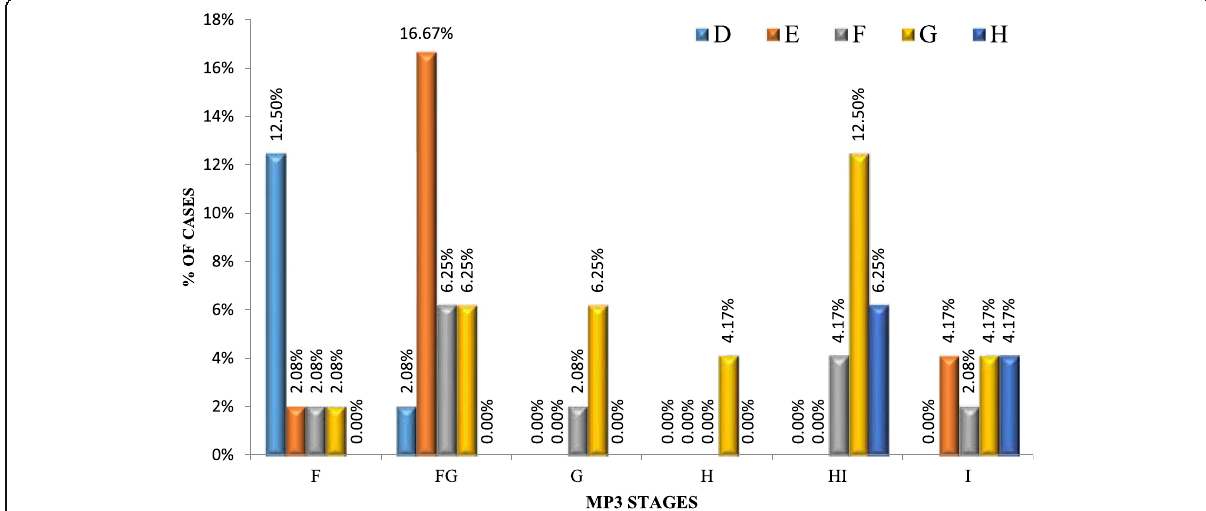
Fig. 4 Correlation between stages of modified MP3 and mandibular second molar in male